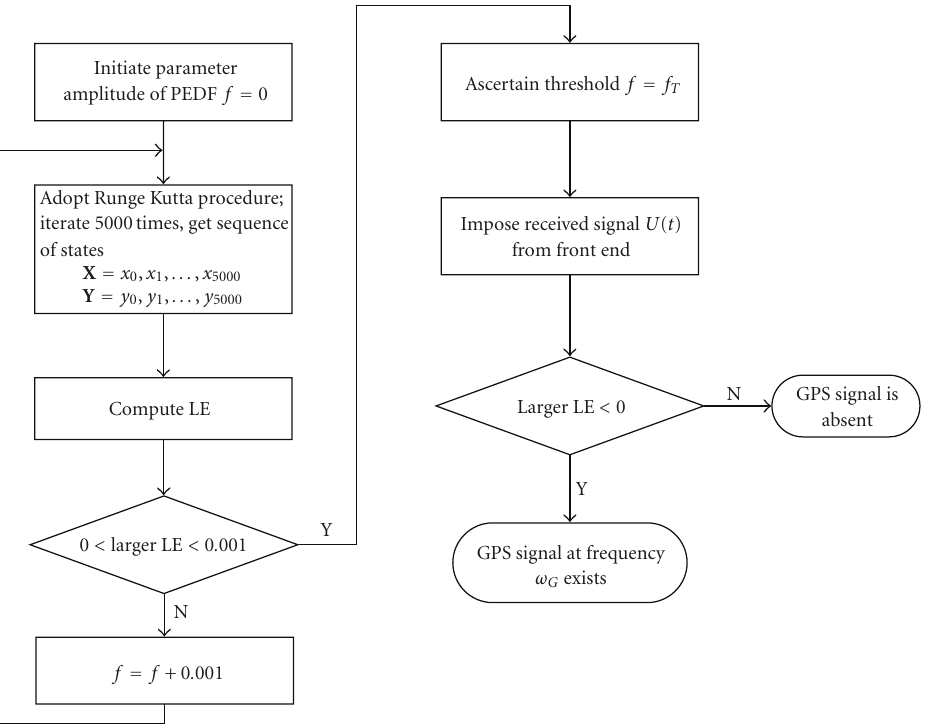
Figure 1: Operation flows of Du ffi ng oscillator acquisition system.